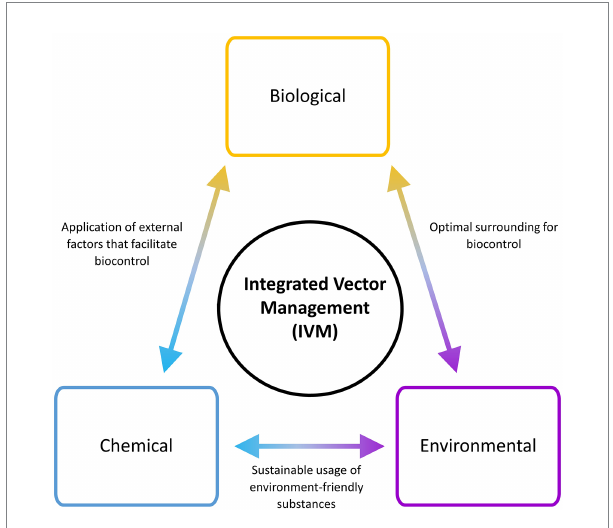
FIGURE 3 Integrated Vector Management (IVM) involving different components in planning and implementation. Multiple components are factored into an IVM strategy to optimize the output of vector